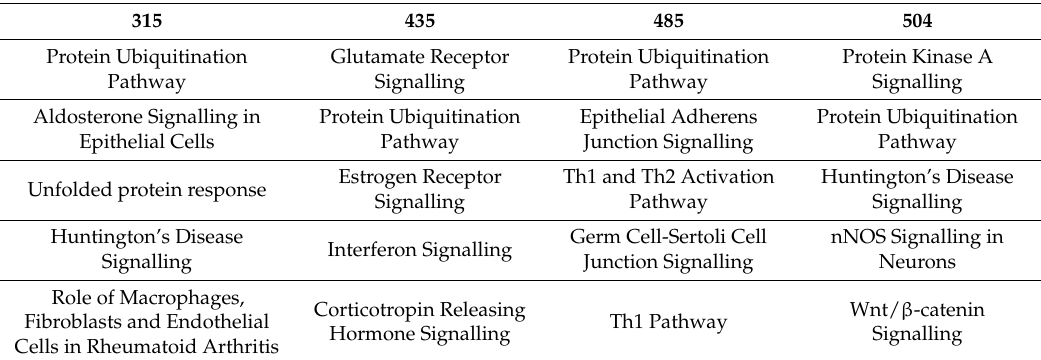
Table 1. List of top 5 significantly enriched pathways in ctDNA. Pathway enrichment analysis was performed for the SNVs detected in each of the ctDNA samples to determine significantly enriched pathways. The top 5 pathways in each ctDNA sample is